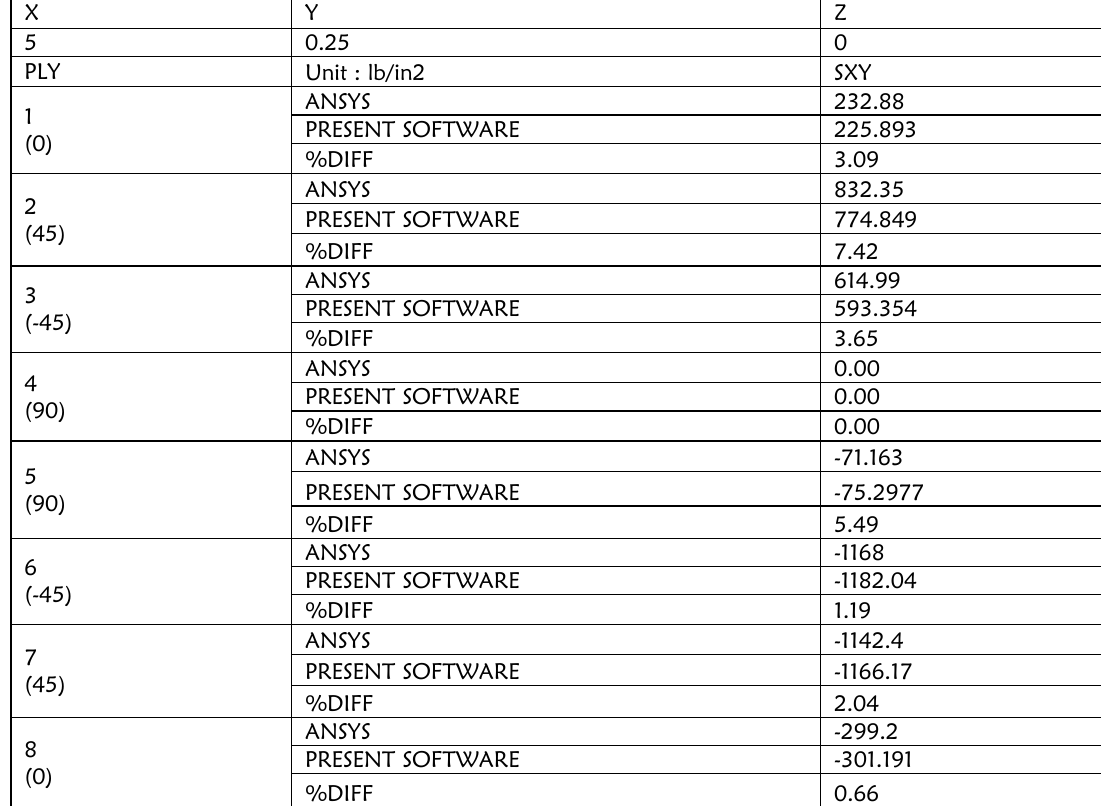
Table 5: Shear stress on the lower flange of C-beam due to torsion